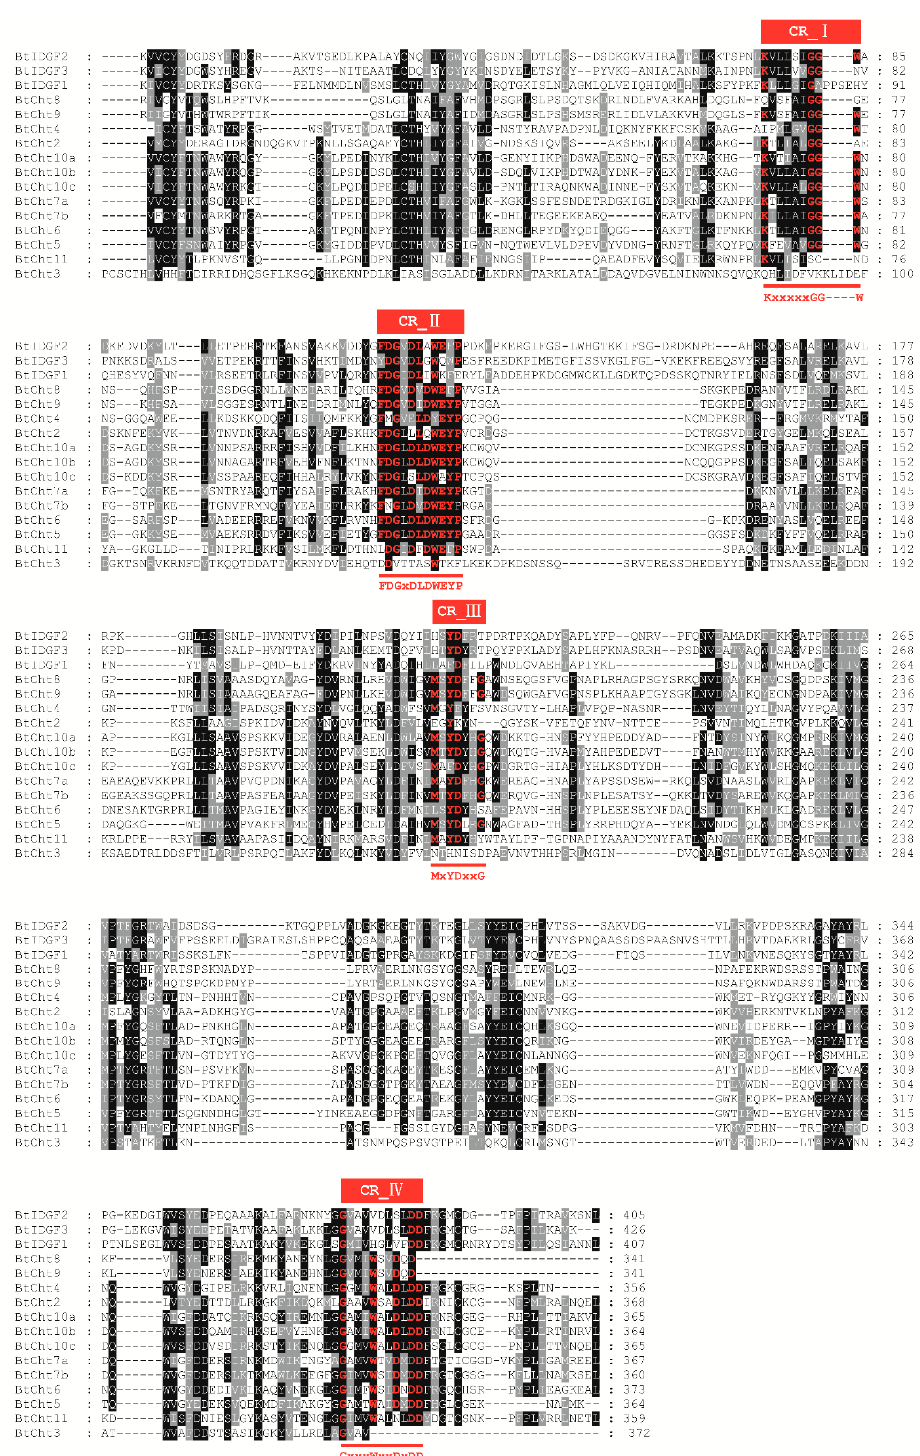
Figure 3. Conserved regions in the glycoside hydrolase family 18 (GH18) domain of 13 chitinase and chitinase-like proteins in B. tabaci . CLUSTALX software was used to conduct the alignment of amino acid sequences of the catalytic domains in GH18 family enzymes. It highlights with different levels of gray and black shading where residues are the same as the consensus of residues for the column. Black shading indicates that all residues are the same in the column. Different sequence homologies are implied by different shading. Regions underlined are the four conserved motifs represented by the sequences KxxxxxGGW, FDGxDLDWEYP, MxYDxxG and GxxxWxxDxDD. Highly conserved residues are marked in red. CR, conserved